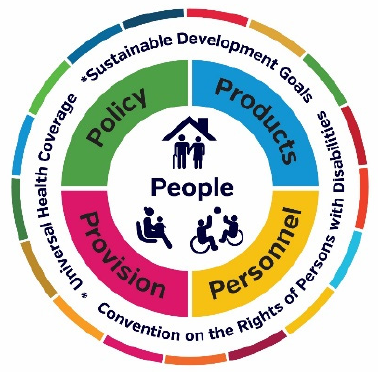
Figure 7. WHO GATE 5 P Framework.